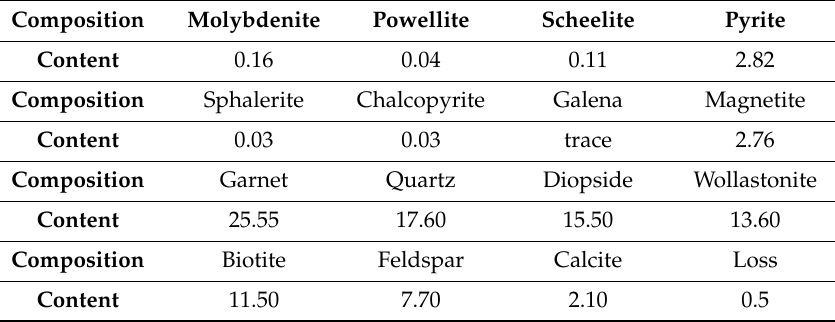
Table 2. The mineralogical composition of the actual Mo ore (wt %).